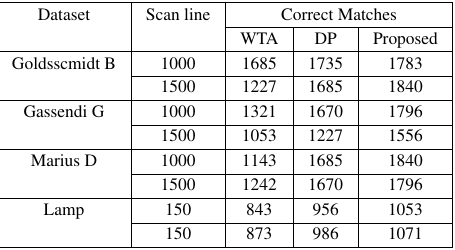
Table 3: Middleburry Stereo Dataset